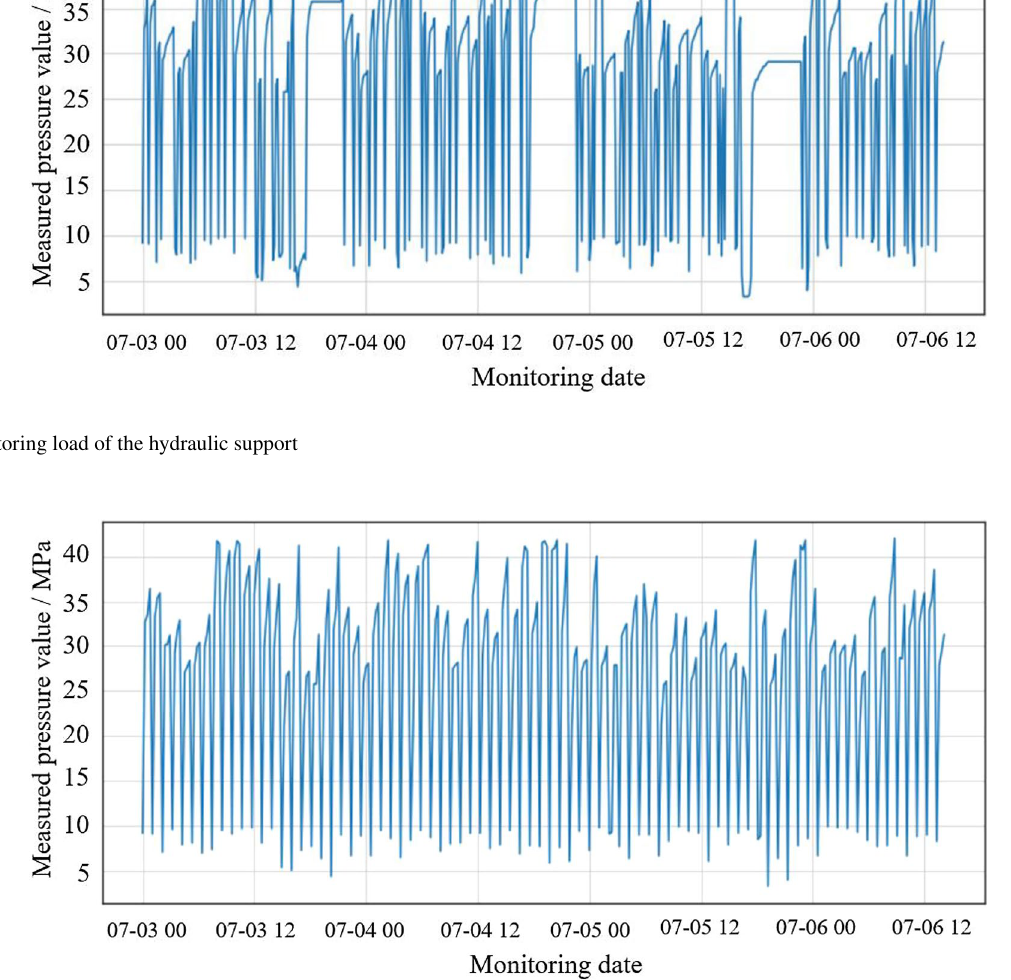
Fig. 5 Preprocessed load data of the support